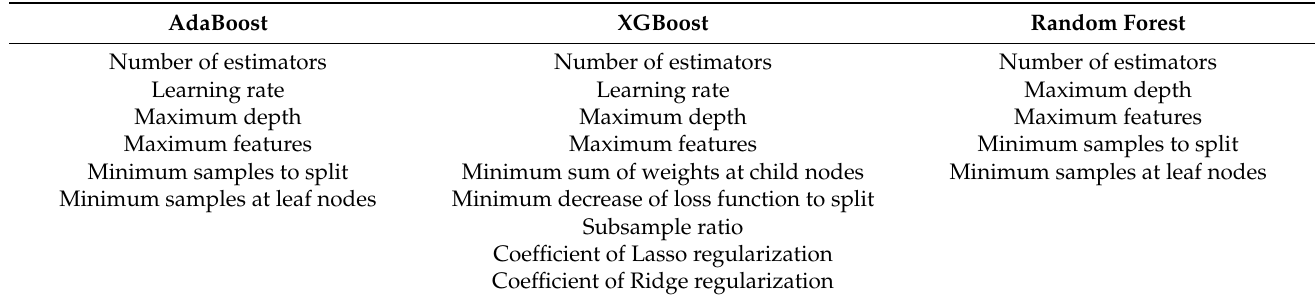
Figure A3. Workflow of random forest model. Subset used to train base estimator is sampled from original set by bootstrap method and final decision is made by major voting. Table A1. Parameters tuned in three ensemble learning methods for classification and regression models in this study. All were tested by a range of values with the midpoint of reference